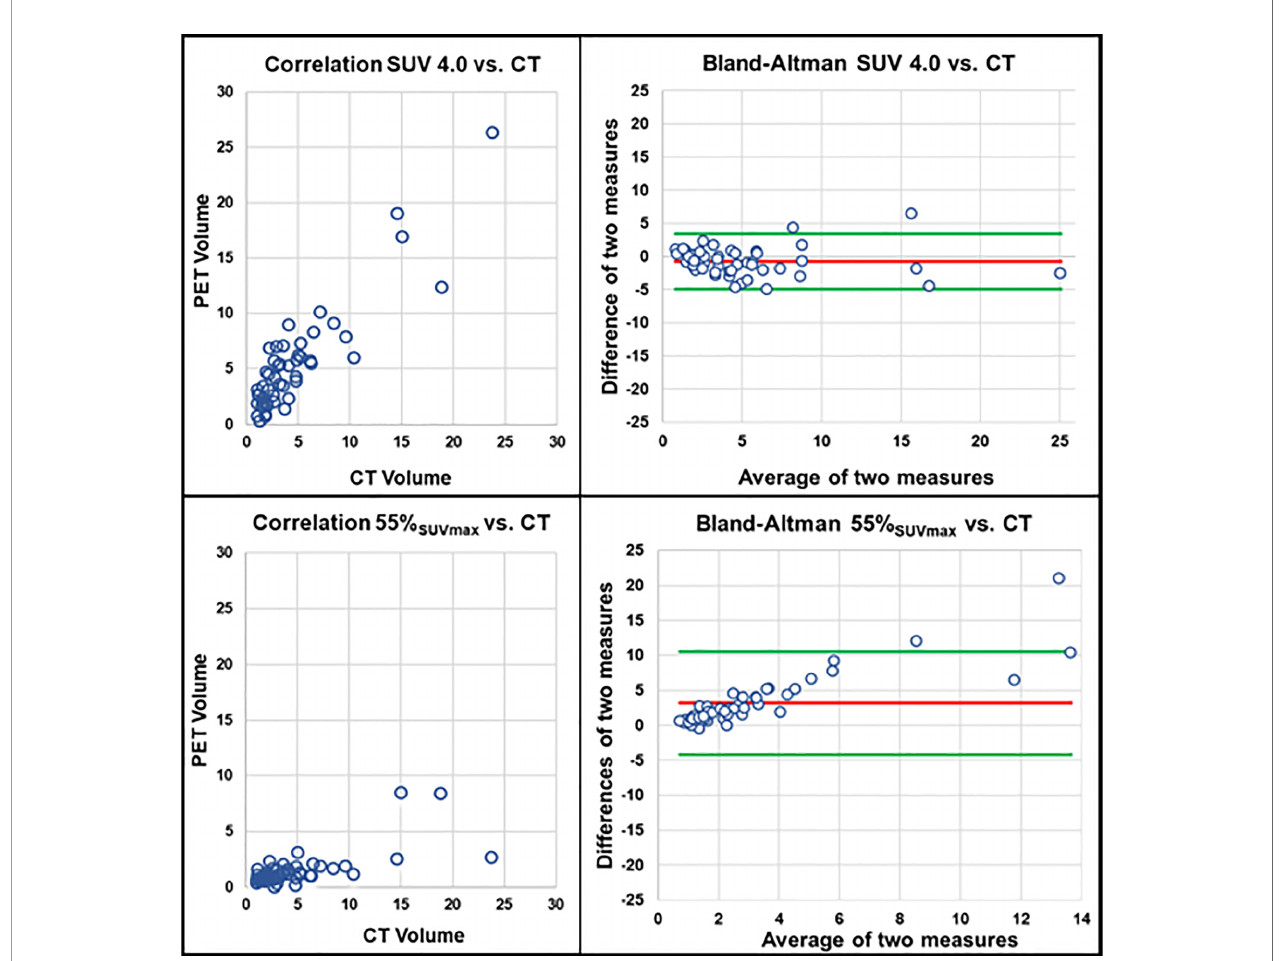
FIGURE 2 | Correlation of PET volumes and CT-based reference standard. Upper row: PET volume SUV 4.0 (r = 0.807, r 2 = 0.651, p < 0.001). Lower row: PET volume isocontour of 55% SUV max (r = 0.627, r 2 = 0.393, p < 0.001); each correlation plot is accompanied by the respective Bland-Altman plot (red line: mean difference of two measures. Green lines: mean difference of two measures ± 1.96 x standard